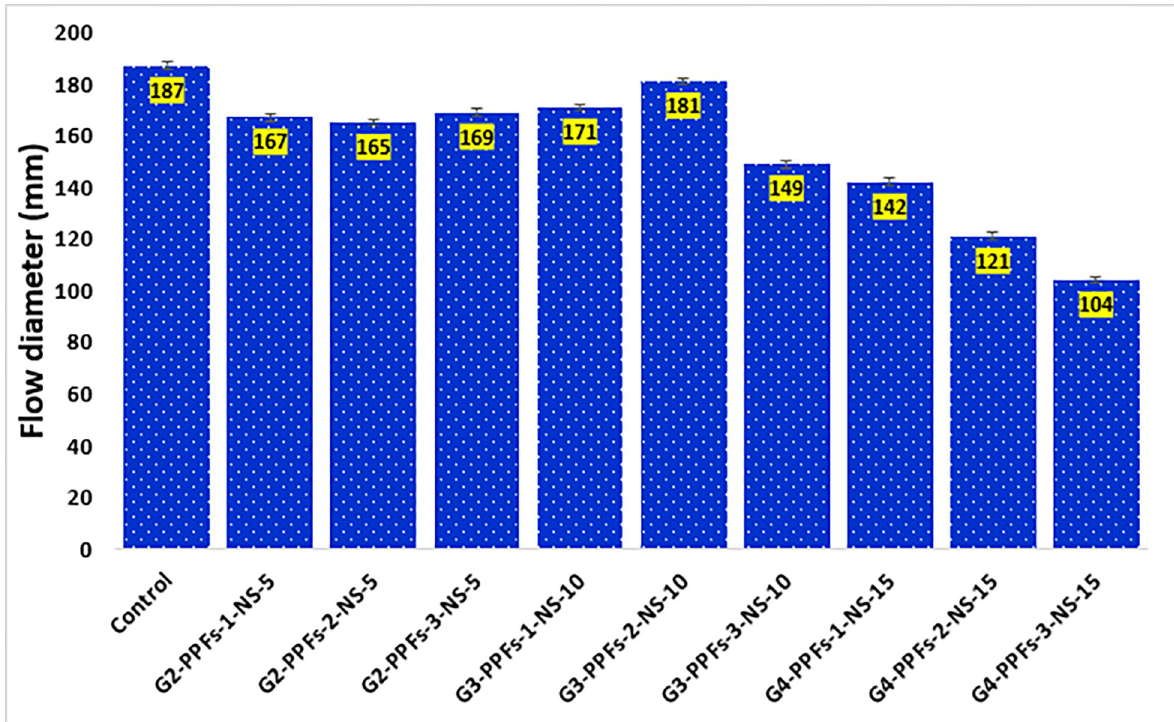
Fig 9. Impact of fibers and NS on flow diameter of